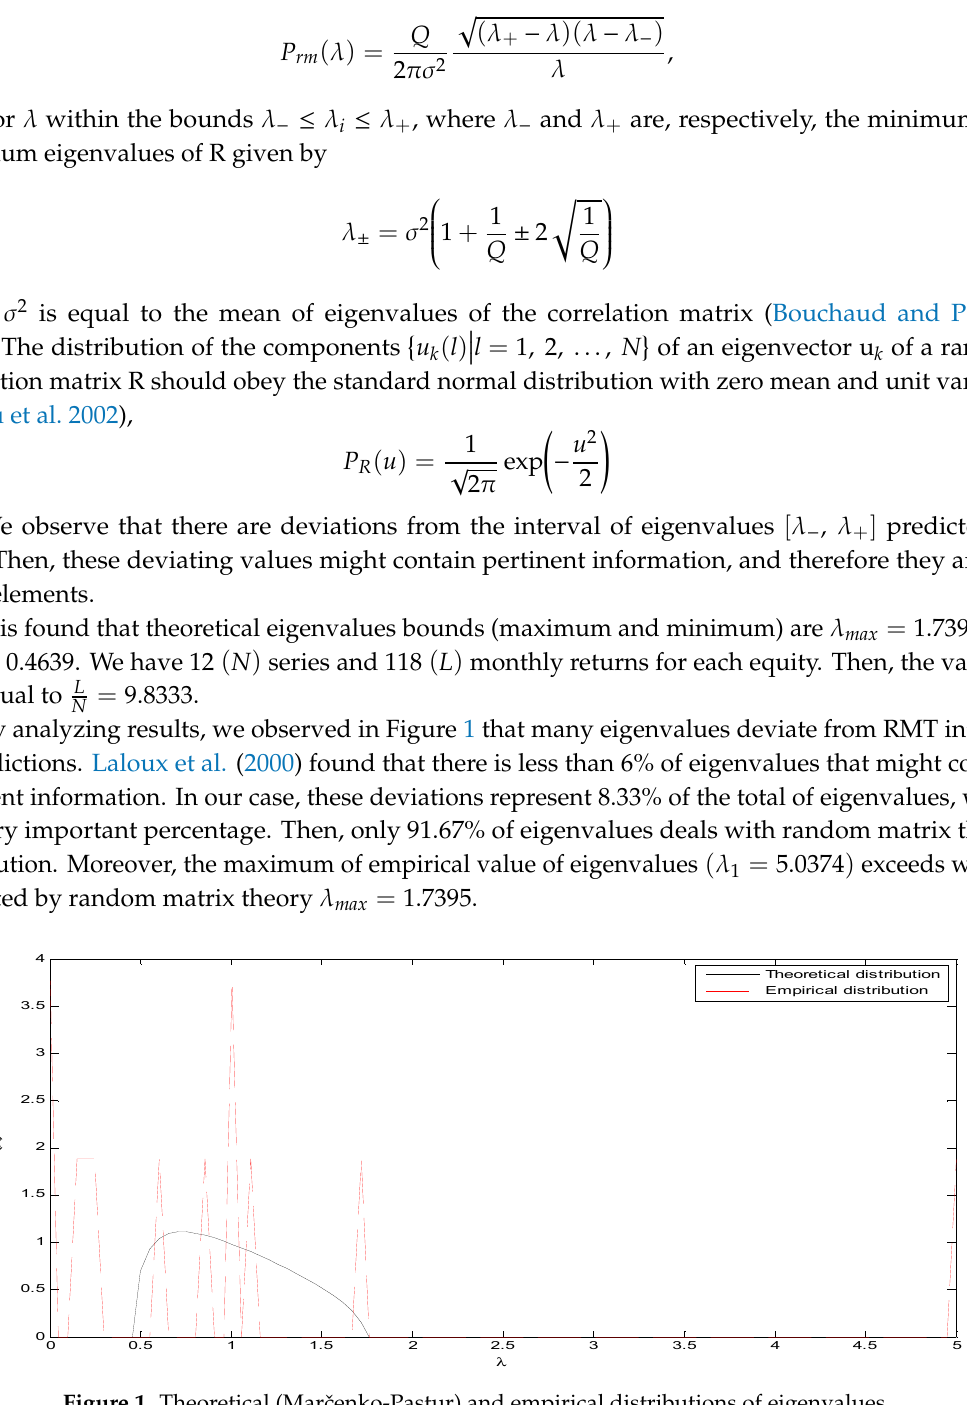
Figure 1. Theoretical (Mar č enko-Pastur) and empirical distributions of eigenvalues .